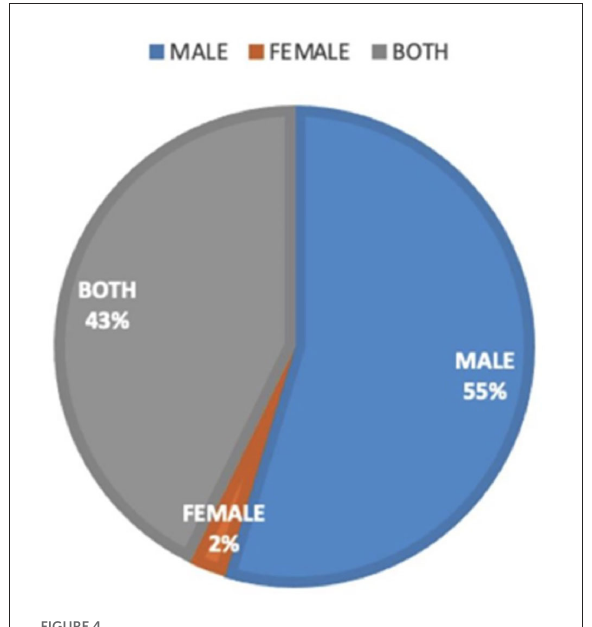
FIGURE4 Mentorship in educational programs. Mentorship educational activities included leadership position according to